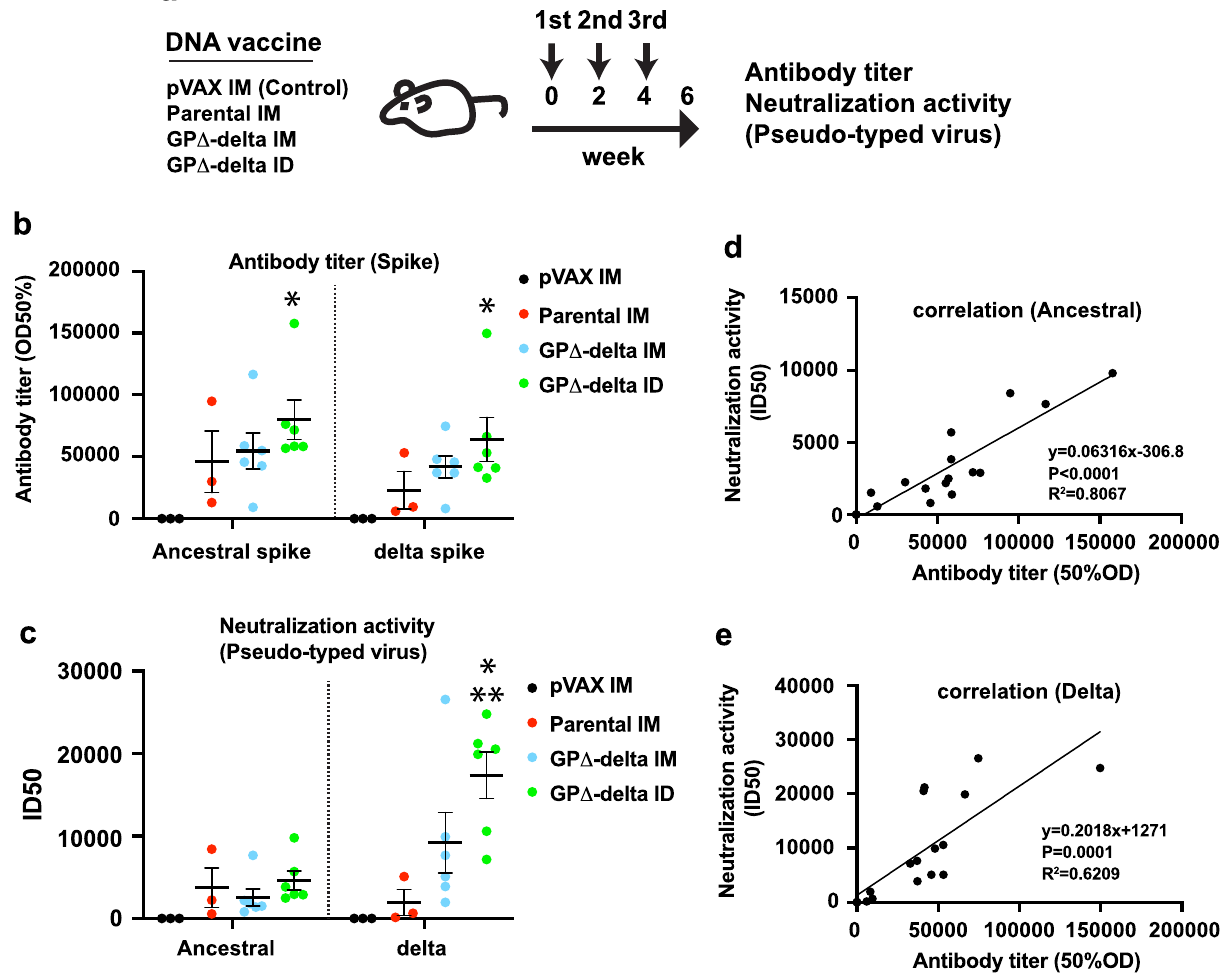
Figure 3. GP∆-delta DNA vaccine induced neutralizing antibodies against delta variant. ( a ) Animal protocol for the control pVAX (intramuscularly; IM), parental DNA (IM), GP∆-delta DNA (IM), or GP∆-delta DNA (intradermally; ID) vaccines using PJI. Control or DNA vaccine was injected three times at 2-week intervals. ( b ) Antibody titers for ancestral and delta spikes, measured using ELISA. *p < 0.01 vs. pVAX1 IM group (Two-way ANOVA with Tukey’s multiple comparison test). ( c ) The neutralizing activity of vaccine-induced antibodies, as determined through VSV-based pseudo-typed viruses carrying the SARS-CoV-2 spike (ancestral or delta variant). The values show the 50% inhibitory dose of serum. *p < 0.01 vs. pVAX1 IM group. **p < 0.05 vs. parental IM group (Two-way ANOVA with Tukey’s multiple comparison test. ( d ) and ( e ) Correlation between ID50 values of immunized serum samples on the pseudo-typed virus and IgG antibody titer for spike. ( d ): Ancestral spike, ( e ): delta variant spike. R 2 , coefficient of determination. Data are shown as mean ± SEM. See also Supplementary Fig.